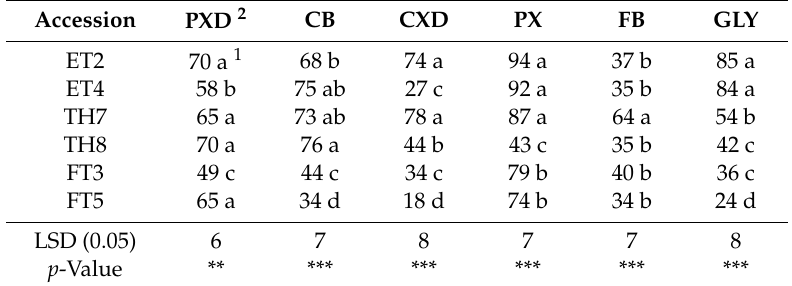
Table 3. E ffi cacy of several herbicides on E. colona accessions at 7 days after treatment (7 DAT). Dry weight of each accession was expressed as % of